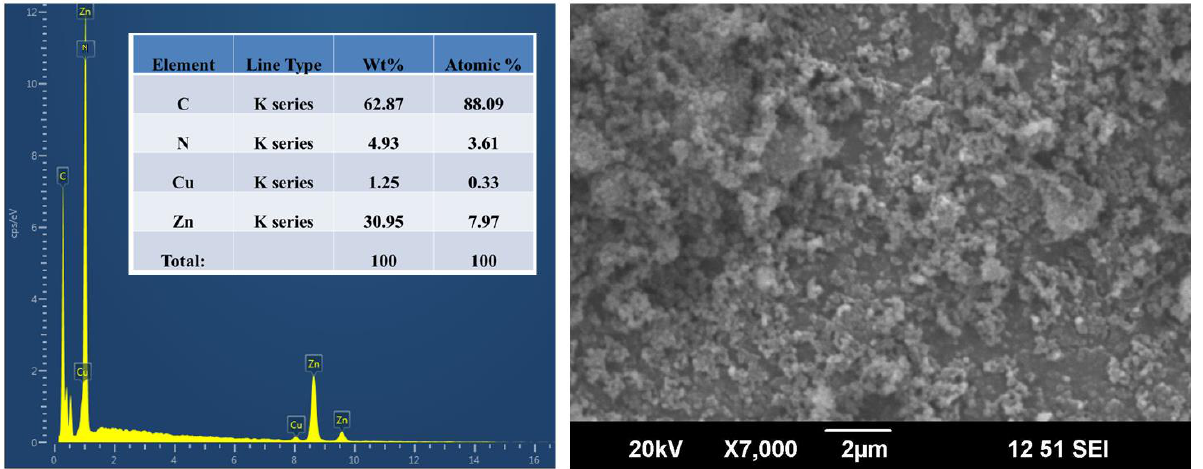
Figure 4. SEM and EDX spectrum of MG@Folate ZIF-L